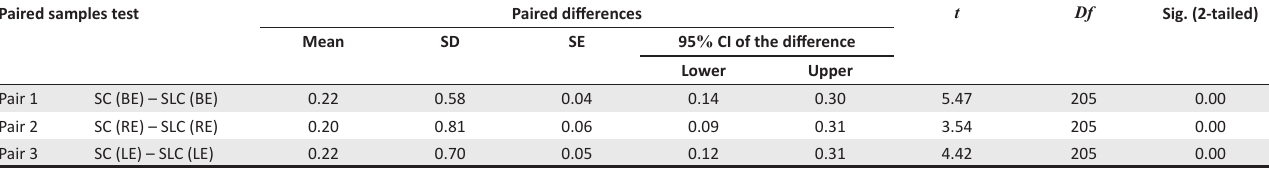
TABLE 3: Mean differences (in min) of the visual acuities obtained with a Snellen chart and Spectrum LogMAR chart for both eyes, right eyes and left eyes. Paired samples test Paired differences